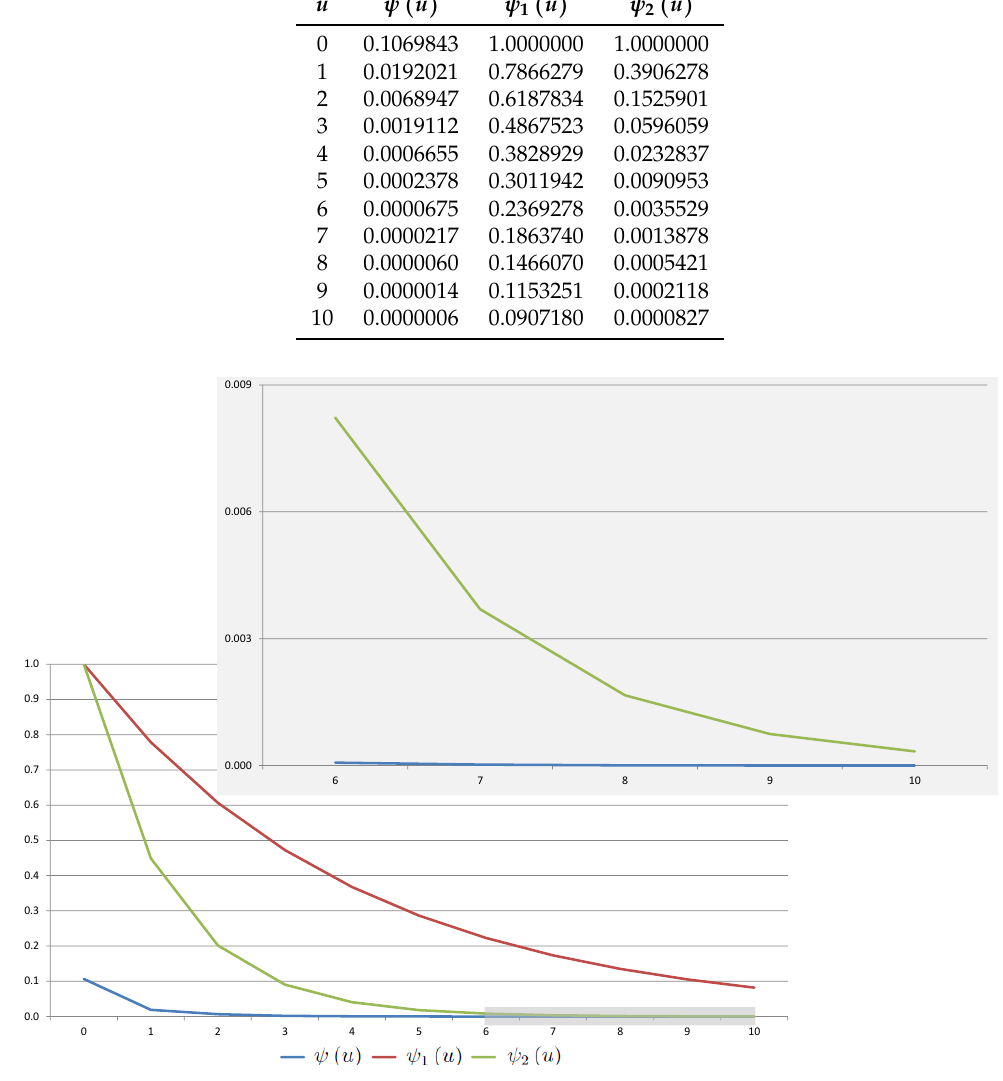
Figure 1. Ruin probability for model of Example